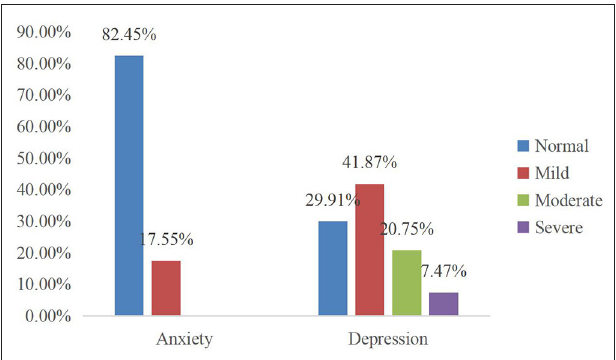
FIGURE 1 | The percentage of anxiety and depression